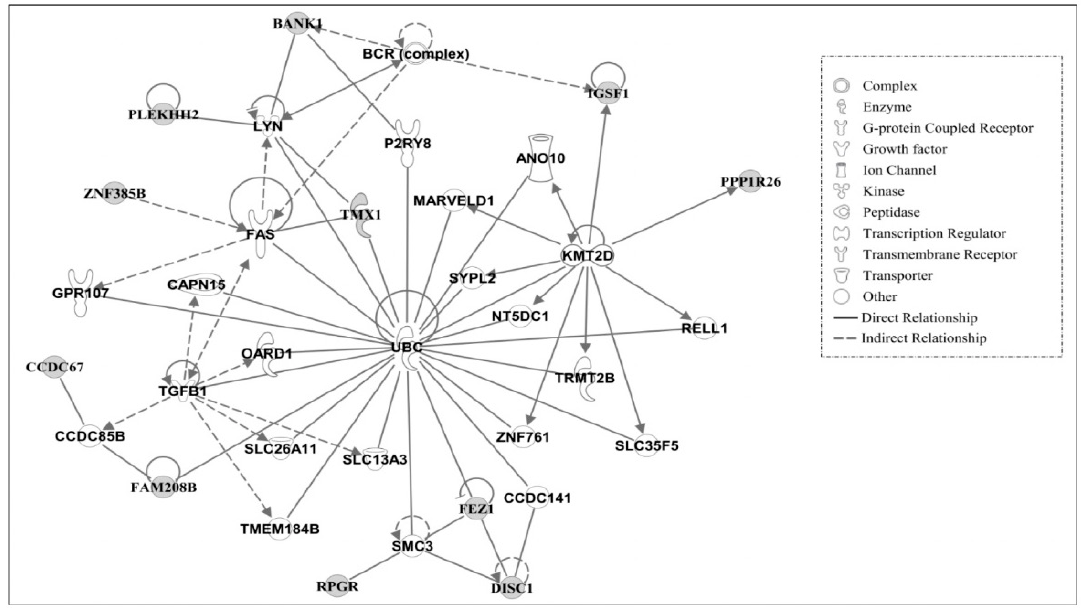
Figure 4. Gene network #2. Molecular interaction and symbols are the same as described in Figure 3.